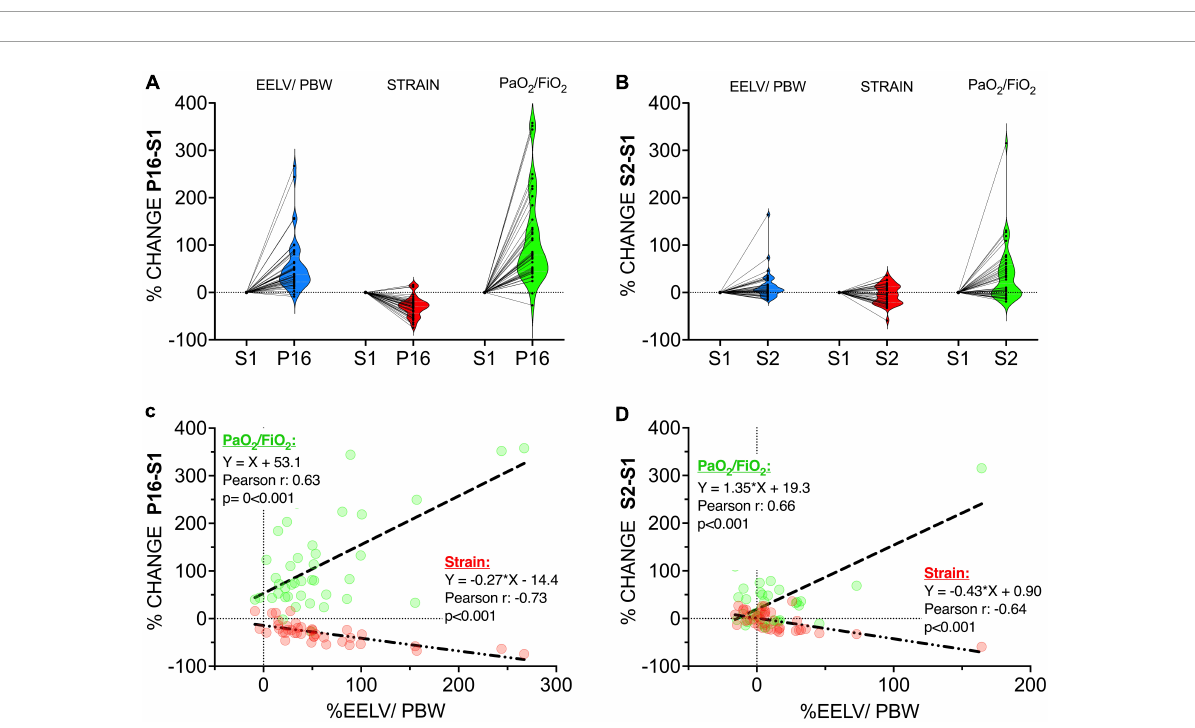
FIGURE3 Upper Panel: Before-after plot of the percentage change from S1 (=%0) to P16 (end of prone position) (A) and from S1 (=%0) to S2 (B) (after turning back to supine position) in end-expiratory lung volume/Predicted Body Weight (EELV/PBW – ml/kg) (blue), strain (red), and PaO 2 /FiO 2 (green). Dots represent individual values. Non-truncated violin plots are stacked to plot the distribution of each parameter. Lower Panel: Correlation coefficients and linear regression lines of the percentage change from S1 (=%0) to P16 (end of prone position) (C) and from S1 (=%0) to S2 (after turning back to supine position) (D) in EELV/PBW versus PaO 2 /FiO 2 (green) and strain (red). Dashed lines represent PaO 2 /FiO 2 and dash-dotted lines represent